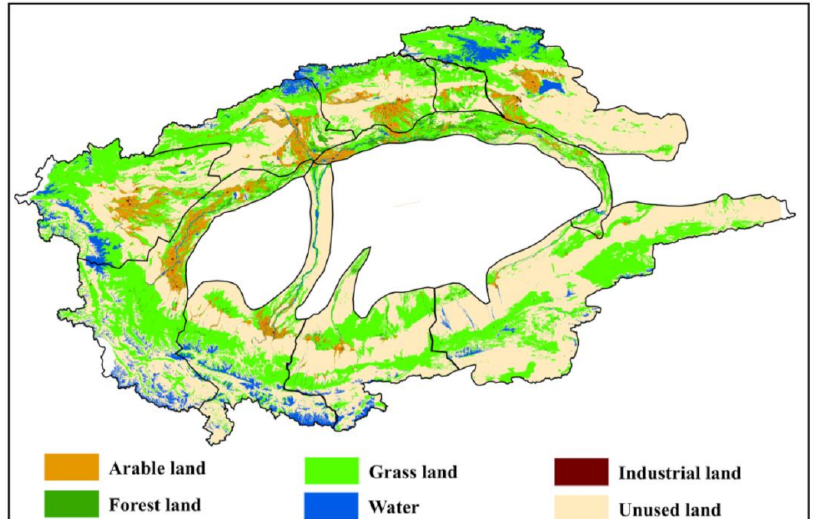
Figure 8. Land-use in Tarim River Basin in